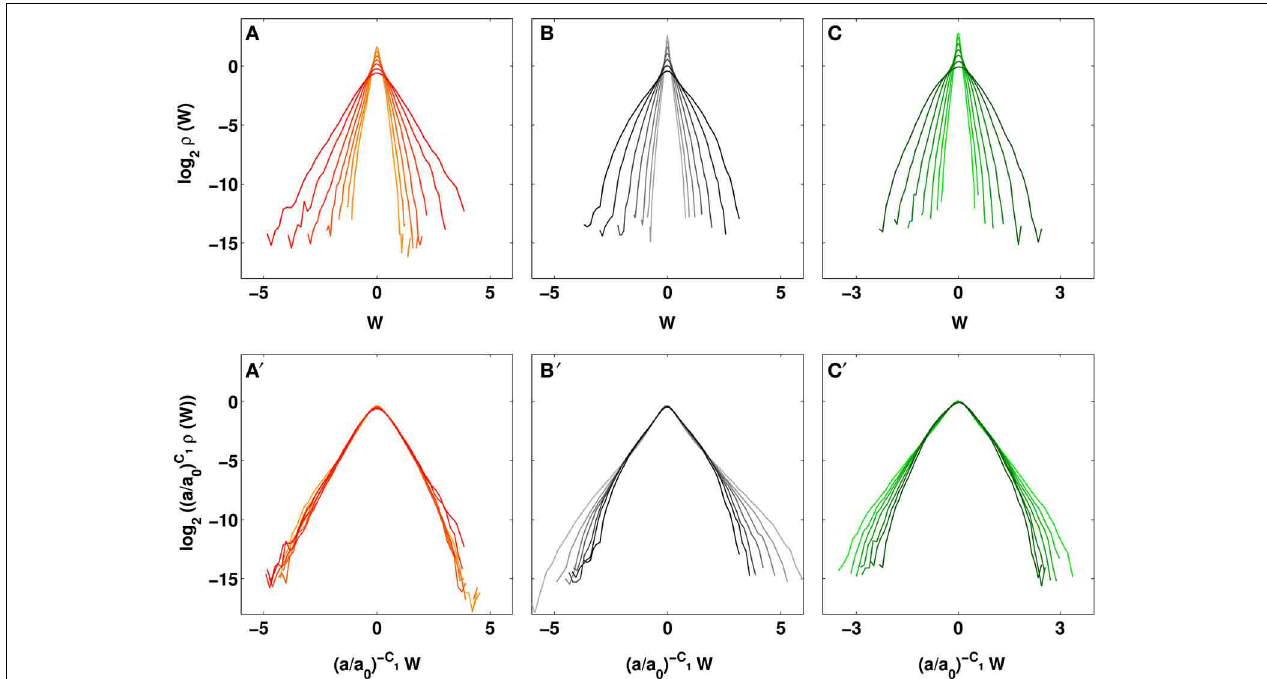
c 1 = 1 . 23, and (C,C (cid:8) ) the healthy right breast of volunteer 14: c 1 = 1 . 17. The different curves correspond to seven different scales from a = 0 . 43s to 2 . 30s, larger scales are in darker shades; a 0 = 0 . 43s. The pdfs were averaged over a 8 × 8 pixel 2